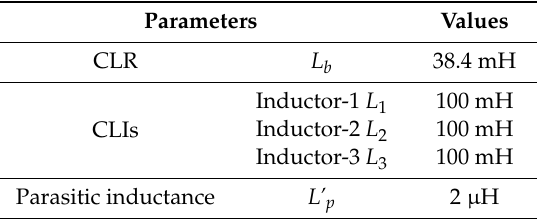
Table A2. Proposed HCB with FCLC